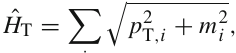
Fig. 2 NLO QCD predictions of the di-muon ( left ) and 4-lepton invariant-mass ( right ) distributions in pp → μ + μ − e + e − at plots show a direct comparison of Sherpa + Recola to the Monte Carlo program employed in Ref.